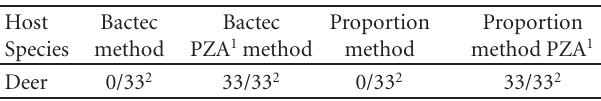
Table 1: Antimicrobial susceptibility results for Michigan deer from